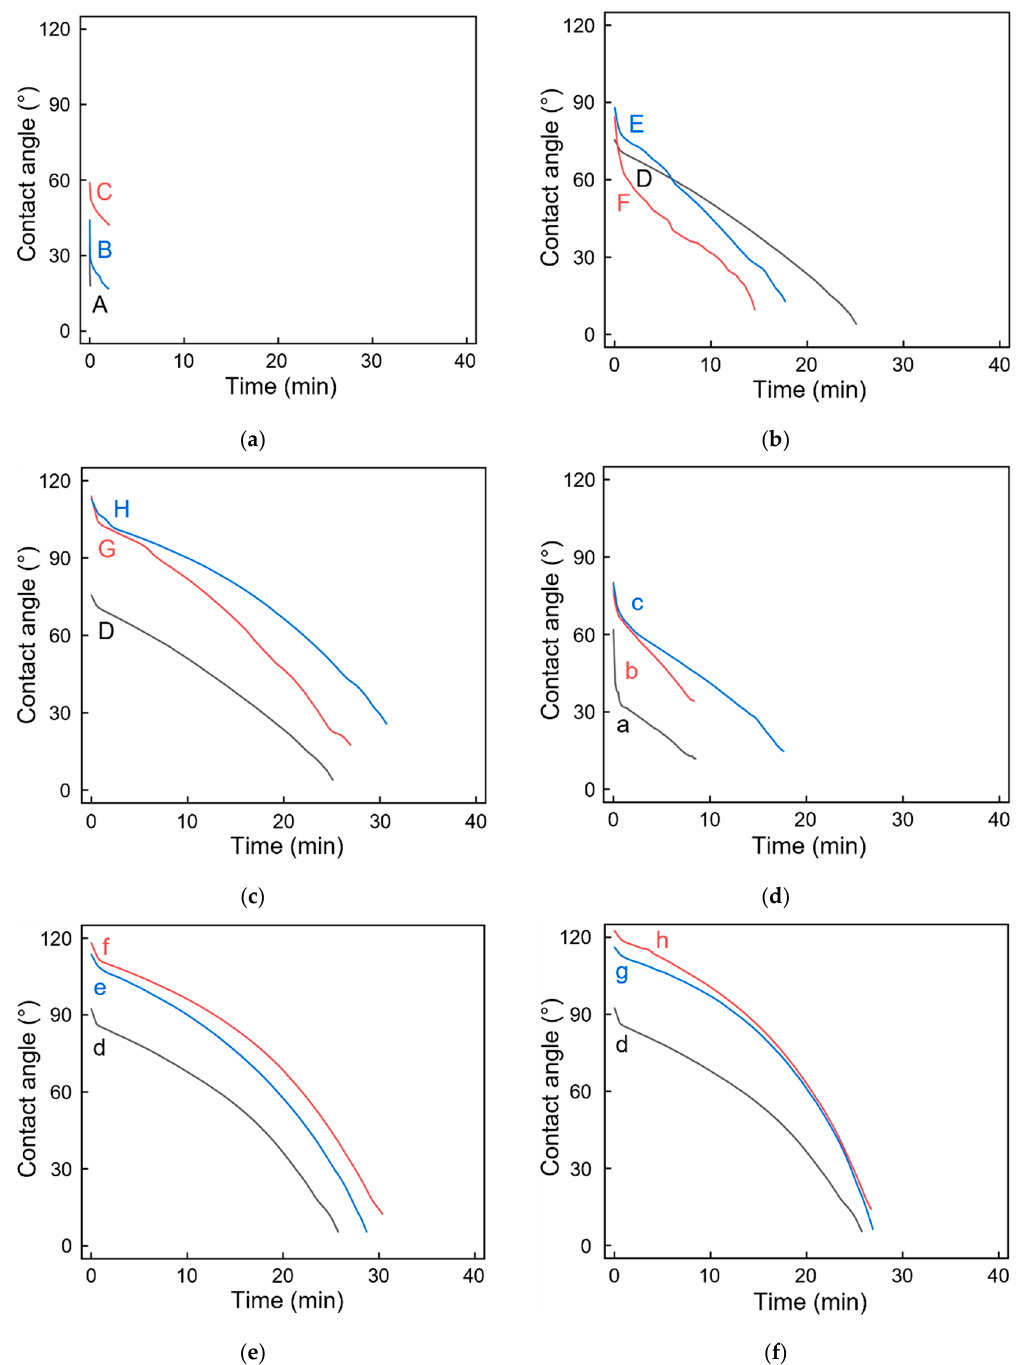
Figure 13. Contact angle analyses of untreated and heat-treated ( a ) PEG–PLA(70)_90 °C, ( b ) PEG–PLA(70) + neat PLA_90 °C, ( c ) PEG–PLA(70) + neat PLA_125 °C, ( d ) PEG–PLA(140)_100 °C, ( e ) PEG–PLA(140) + neat PLA_100 °C, and ( f ) PEG–PLA(140) + neat PLA_125 °C samples. The durations and notations corresponding to this heat treatment are shown in